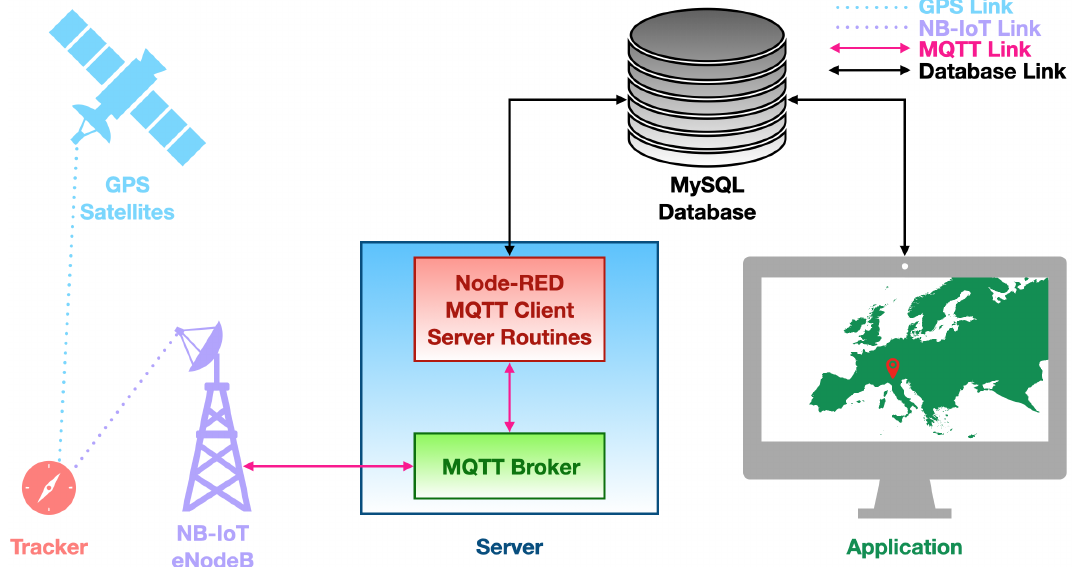
Figure 1. System architecture block